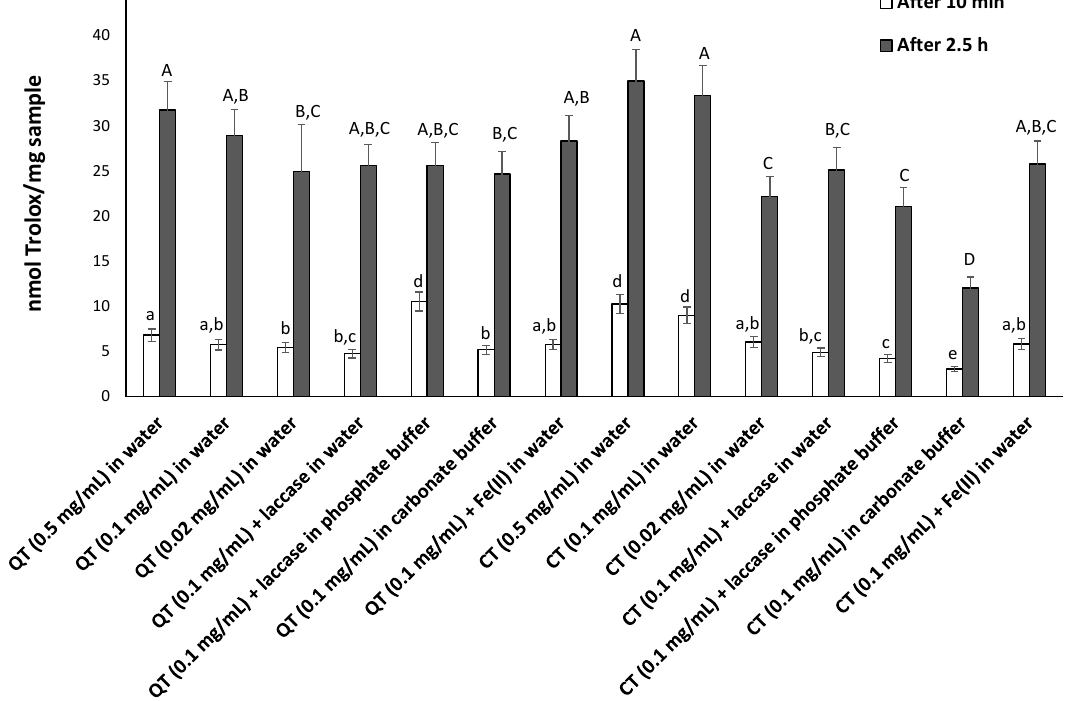
Figure 5. Trolox eqs determined at 10 min and 2.5 h for the tannin-coated nylon membrane filters in the ferric reducing/antioxidant power (FRAP) assay. Reported are the mean ± SD values from at least three experiments. Values in a series without common letters are significantly different ( p < 0.05).